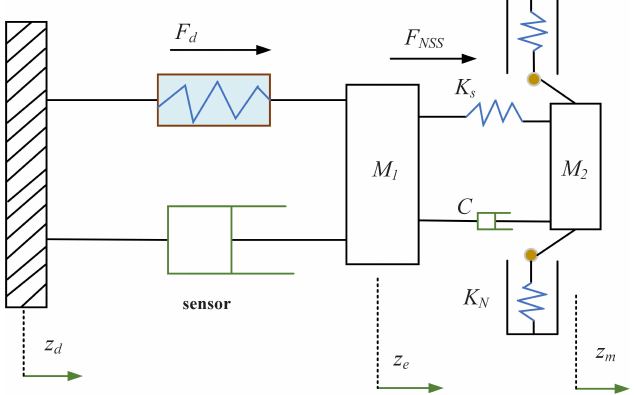
Figure 8. Schematic diagram of the dynamics of the SEA-driven